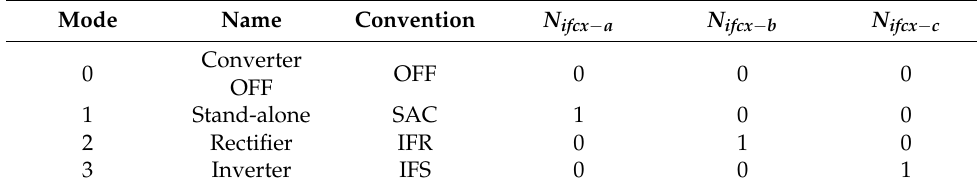
Table 5. Operation modes of the IFCs.